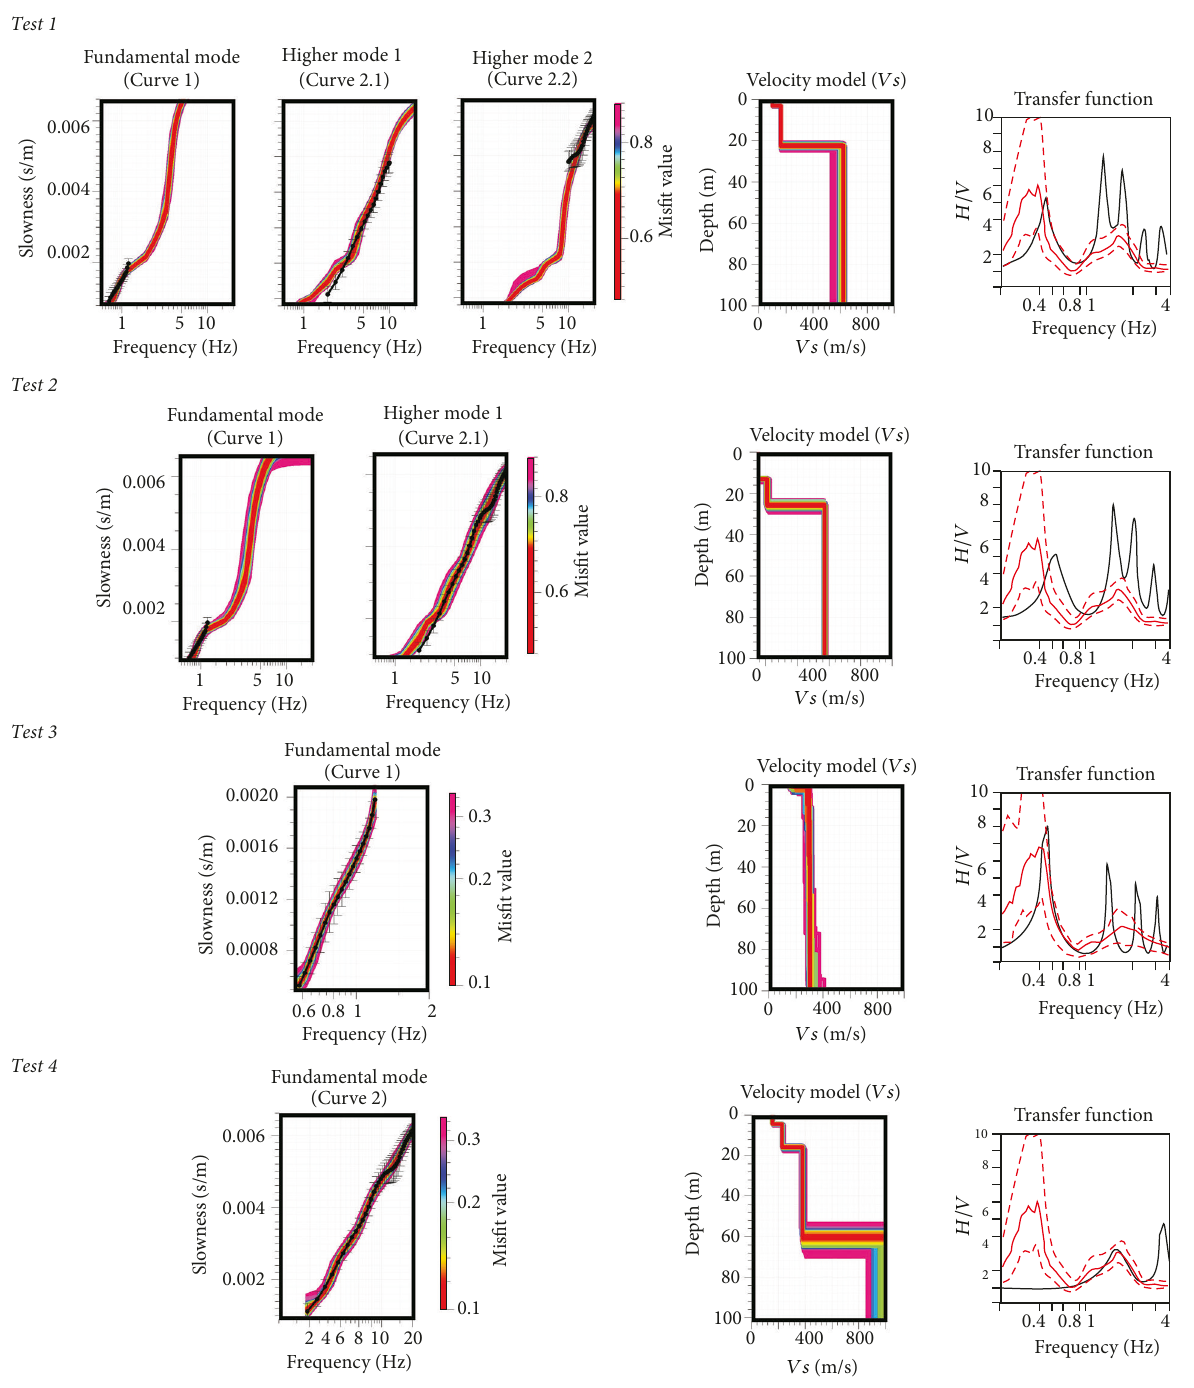
Figure 4: Results for the four tests, from left to right: the inversion of the dispersion curves, the velocity profiles of shear waves ( 𝑉𝑠 ), and the correspondence of the theoretical transfer function (FTT; black line) obtained from the velocity profiles inversion and the empirical transfer function (FTE; red line) obtained from the spectral ratios for site